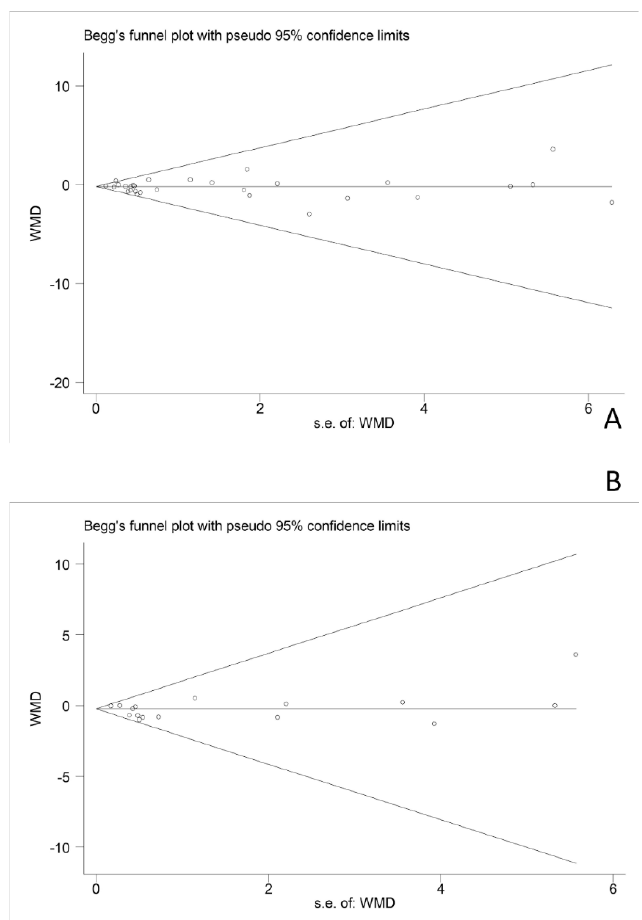
Figure 6. Publication bias funnel chart of the effects of soy products on body weight ( A ) and BMI ( B ) in overweight or obese people.